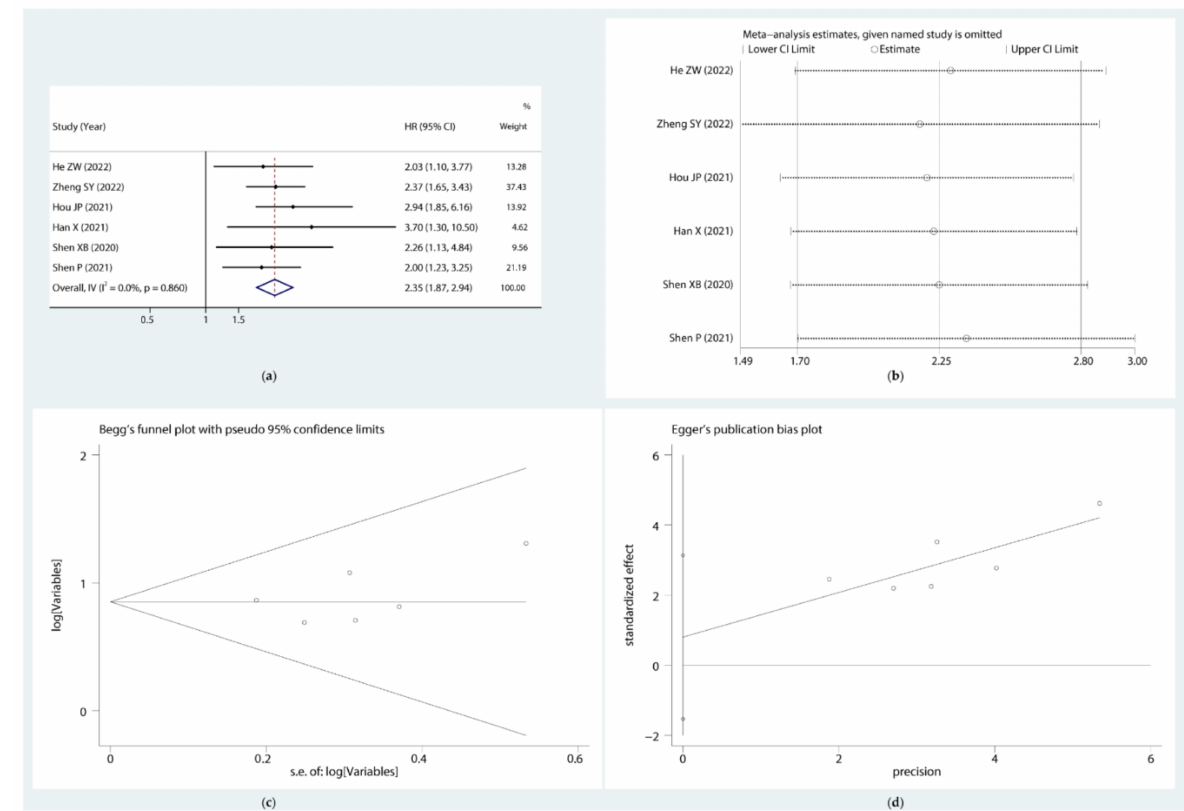
Figure 5. Forest plot of the OS ( a ), sensitivity analysis ( b ), and publication bias judged by Begg’s ( c ) and Egger’s ( d ) funnel plots of combined circRNAs in pancreatic